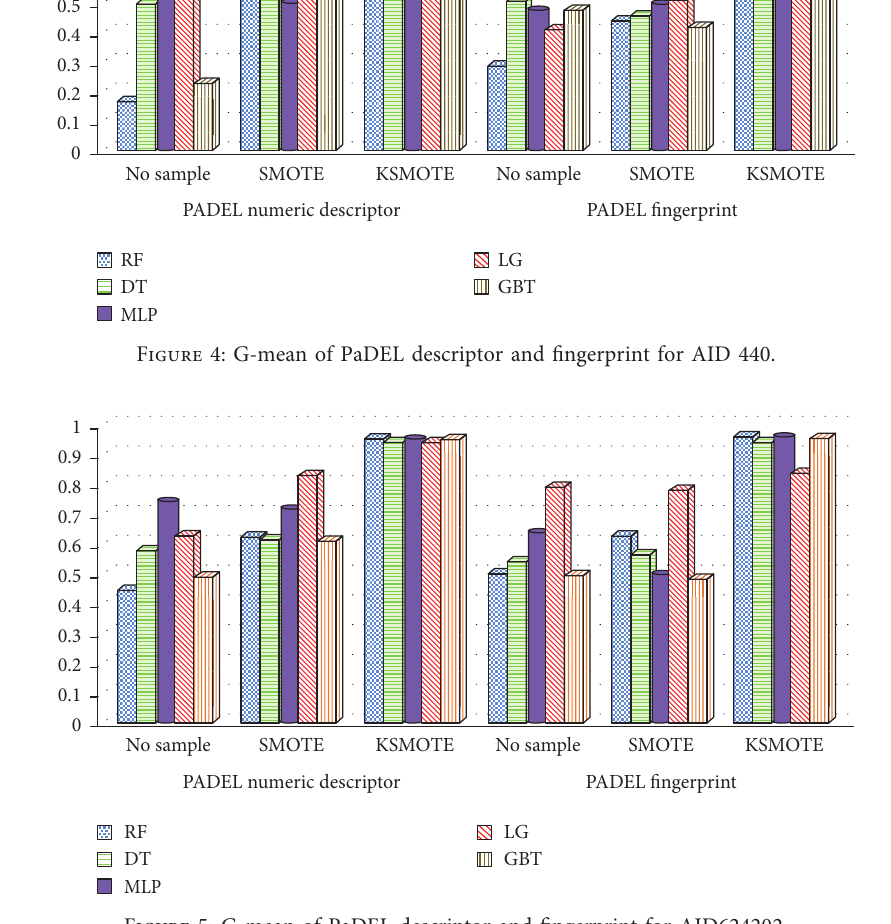
Figure 5: G-mean of PaDEL descriptor and fingerprint for